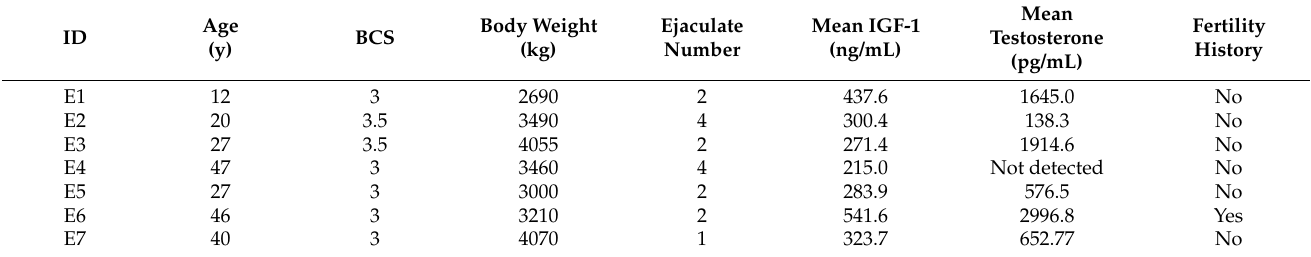
Table 1. Summary of age, body condition score (BCS), bodyweight, total ejaculate number, mean serum IGF-1, testosterone concentration and fertility history of seven Asian elephant